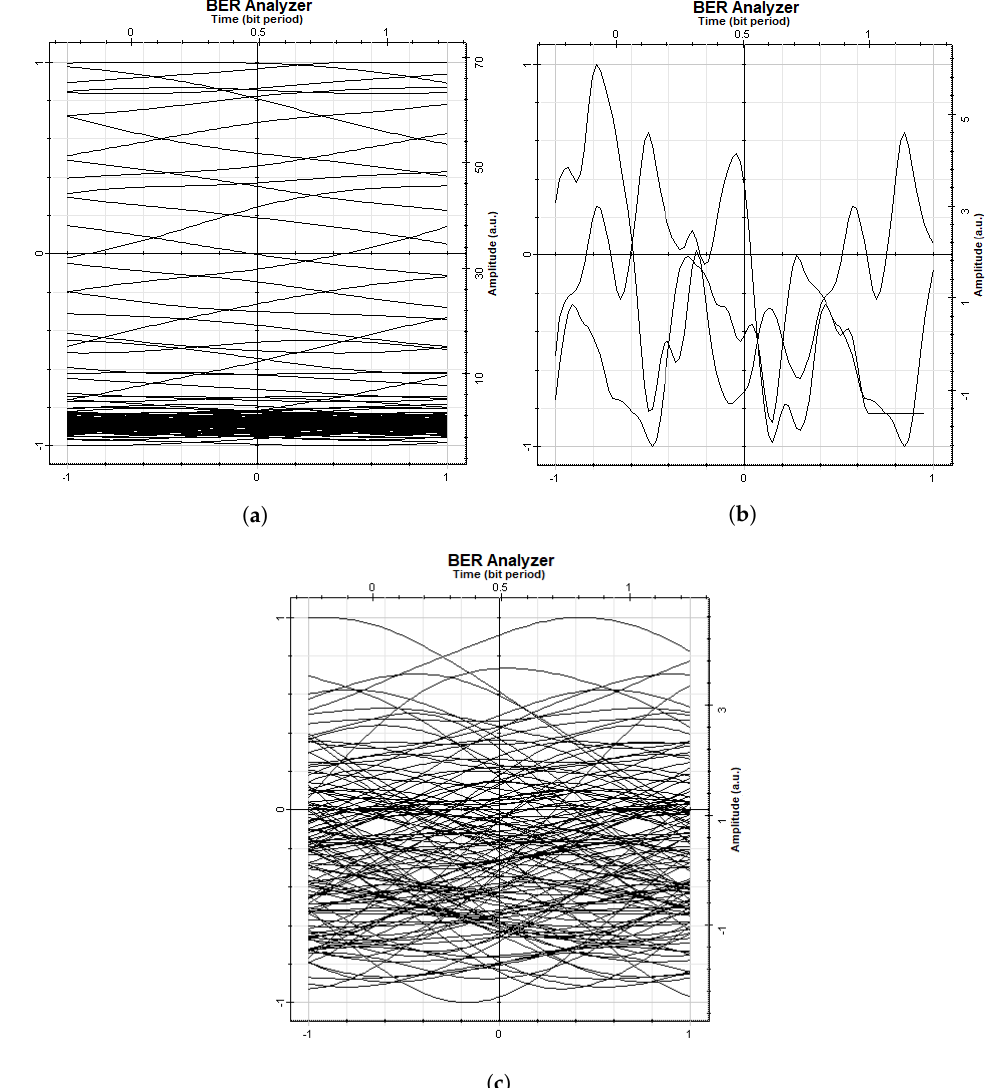
Figure 14. Eye diagram results. ( a ) LOS. ( b ) Single LED NLOS. ( c ) Dual LED